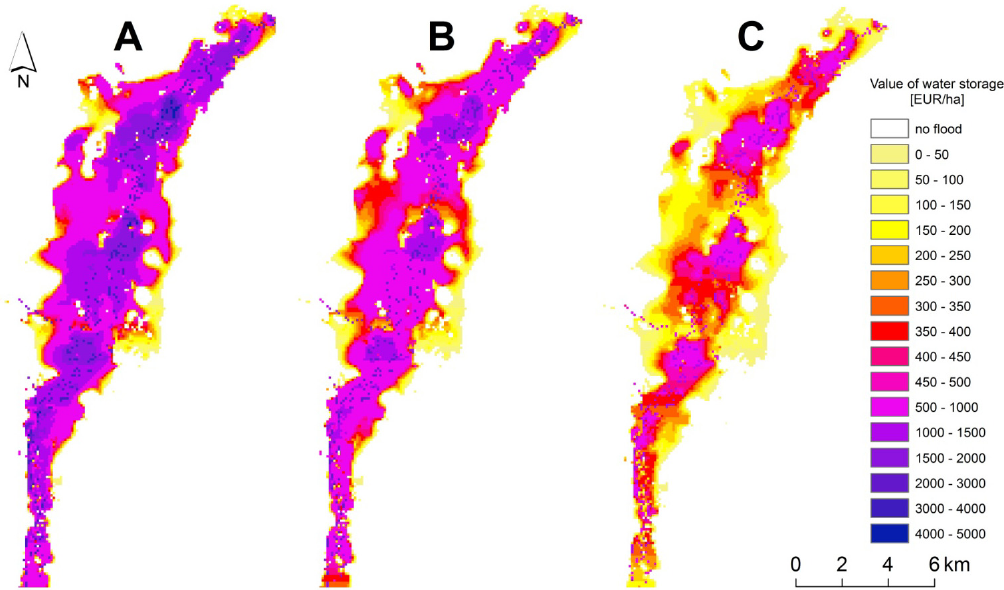
Figure 8. Maps of the monetary values of stored water [EUR/ha] in the Lower Biebrza Basin in conditions of flood of 50% exceedance probability, assuming that the area was flooded ( A ) 3 months; ( B ) 2 months; and ( C ) 1